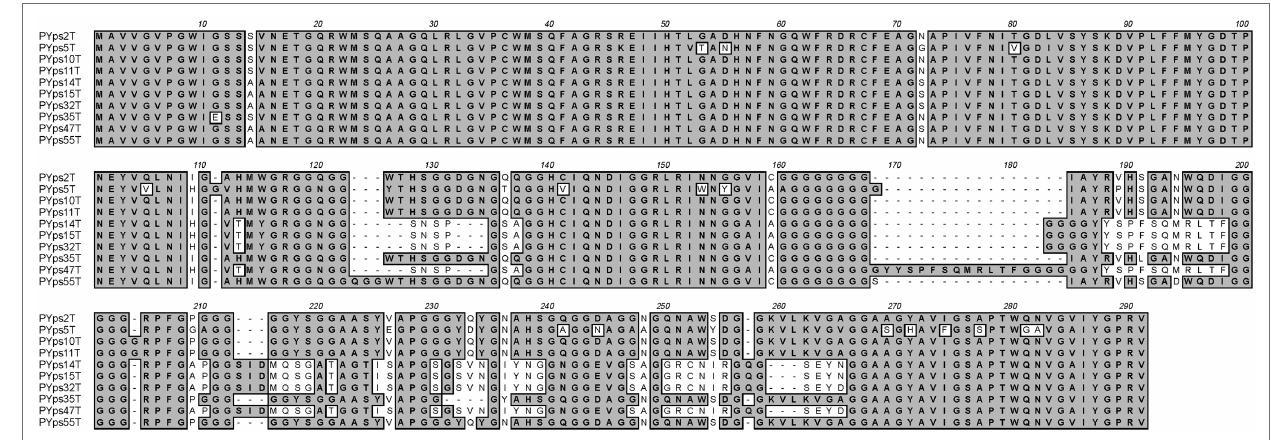
FIGURE 4 | Alignment of the PYps2T group tail fiber adhesins (gp38 in